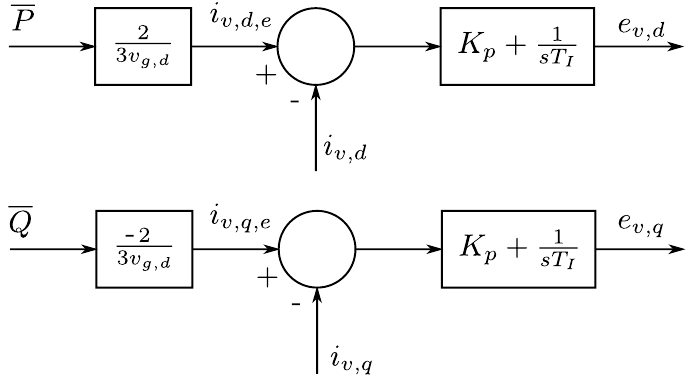
Figure 5. Slave terminal output current